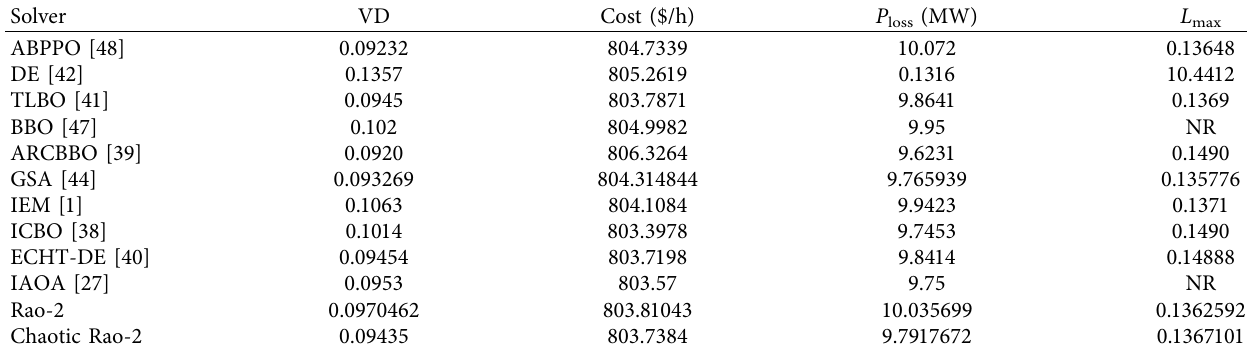
Table 7: Comparison study for case